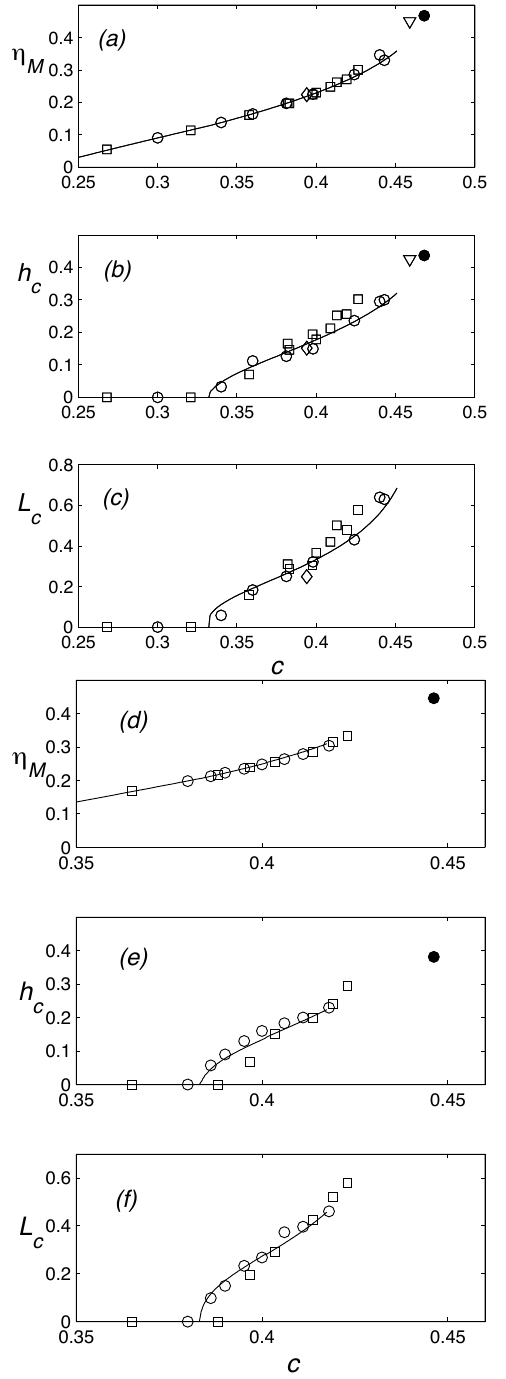
Fig. 12. Comparison of wave amplitude η M , core height h c , and core length L c versus wave speed c from the stagnant-core DJL so- lutions (solid lines), numerical solutions initiated with the model so- lutions (open circles), and from the lock-release runs (open squares) for λ = 8, (a) – (c) , and λ = 4, (d) – (f) . The solid circles show the the- oretical conjugate state limits. The open diamonds in (a)–(c) show the equilibrated wave initiated with a stagnant-core DJL solution with s c = 1 . 1 and the open triangles show the conjugate state prop- erties from a lock-release numerical run from White and Helfrich (2008).